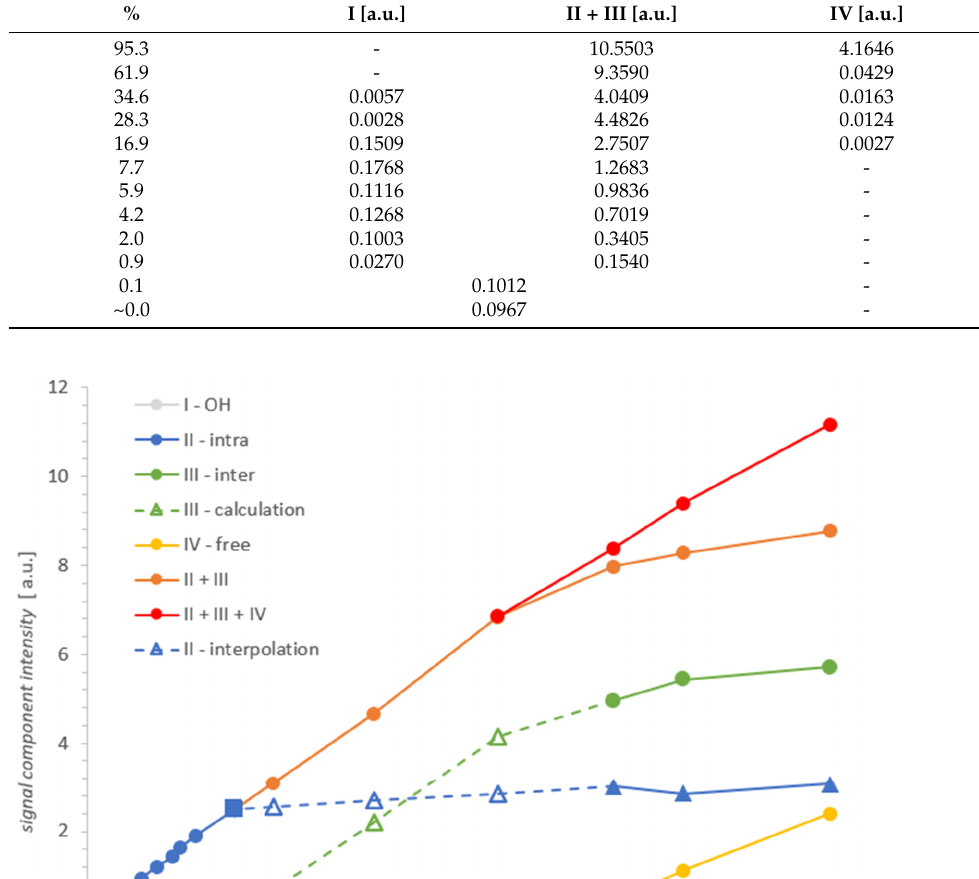
Figure 6. Individual contributions of water in SBA-15 as a function of water saturation.